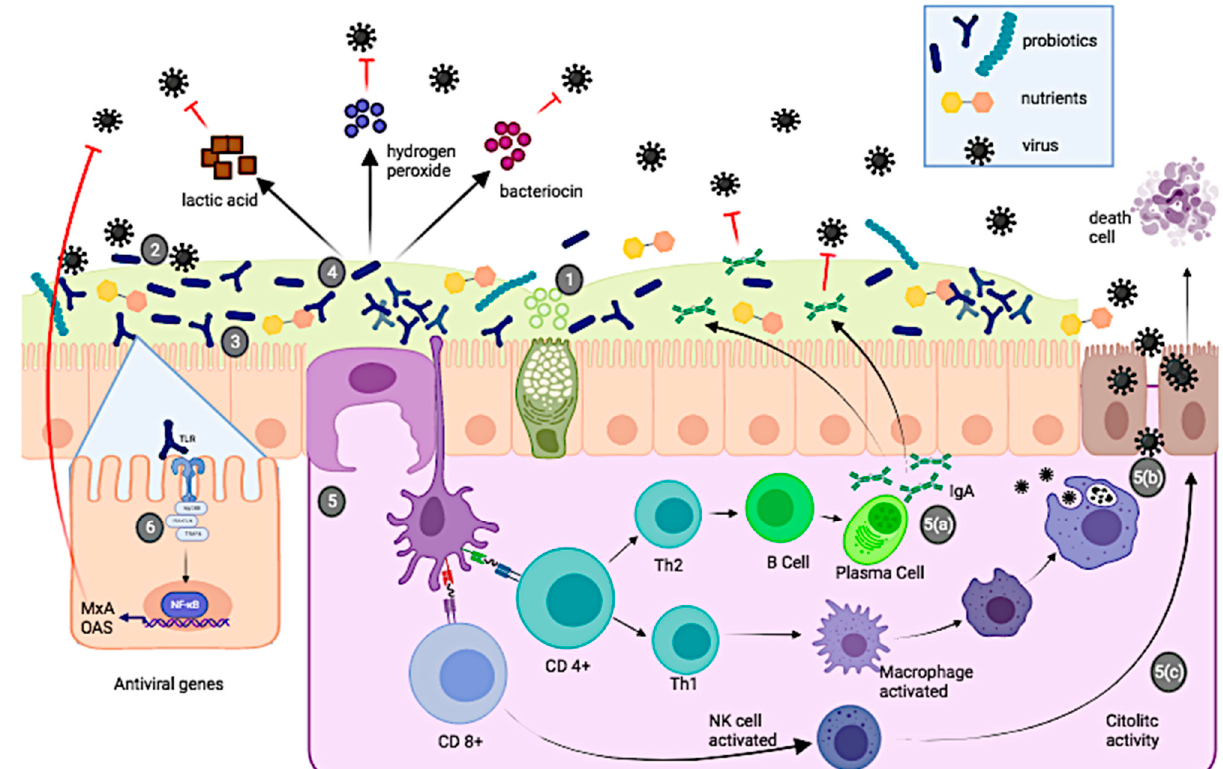
Figure 1. Antiviral effects of probiotics. The major impact of probiotics against viral infections is based on the probiotic- microbiota crosstalk with the aim of maintaining the integrity of the intestinal barrier by: (1) promotion of mucin secretion, (2) adhesion of probiotics to the epithelial surface with the aim of blocking viral attachment either by steric hindrance, covering receptor sites in a non-specific manner, or competing for specific carbohydrate receptors, (3) binding of probiotics directly to epithelial cells, (4) production of antimicrobial compounds such as lactic acid, hydrogen peroxide, bacteriocins and (5) modulation of the immune system [8,9,32,33]. In the case of the immune system these include: 5(a) type 2 T-helper cells (Th2) capable of producing high levels of IgA [34]; 5(b) type 1 T-helper cells (Th1) that will activate phagocytes and promotes virus clearance, and, 5(c) upon activation, CD8+ T lymphocytes differentiate into cytotoxic T lymphocytes (CTLs) which will kill virus-infected cells [39,40]. Probiotics likewise exert immunomodulatory activities through interaction with TLR receptors (6), resulting in the initiation of downstream signaling cascades, such as NF- κβ , which induce the expression of antiviral genes (MxA and OAS) [37]. (This figure was created with Biorender.com, access date: 29 July 2021).